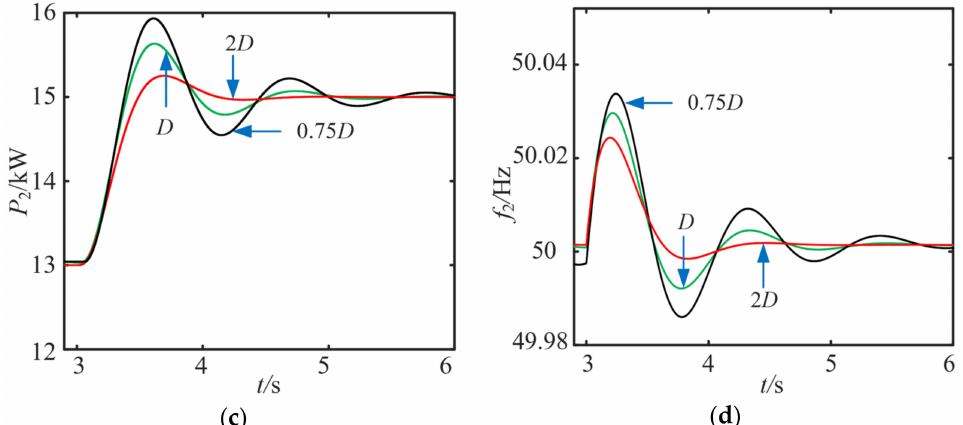
Figure 15. Simulation waveforms with different damping coefficients: ( a ) active power of VSG1;